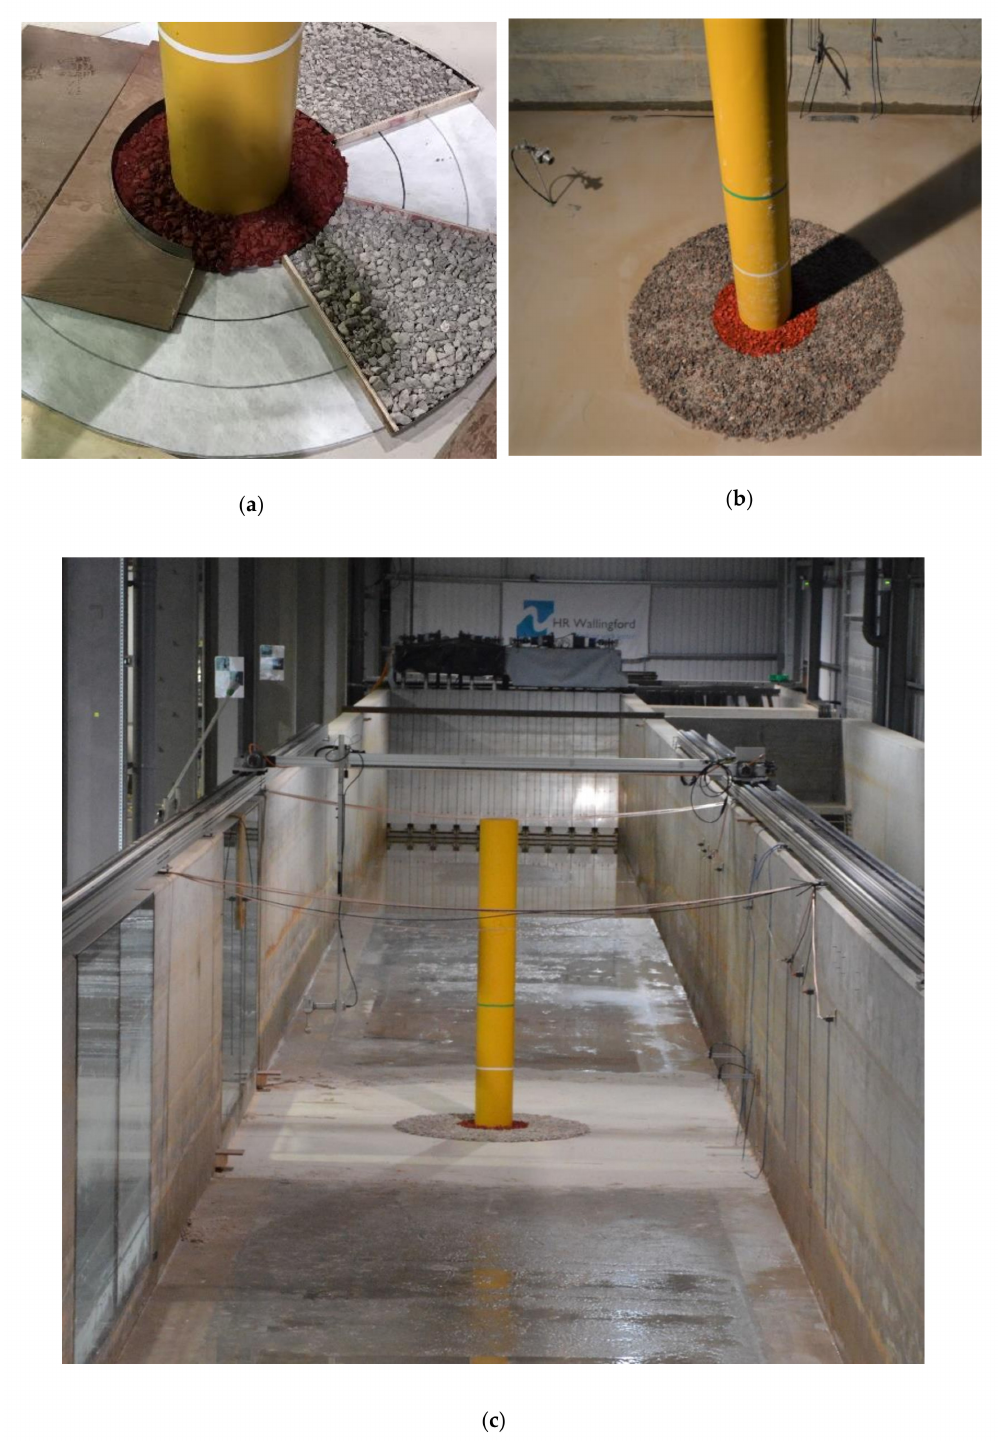
Figure 5. Experimental set-up in PROTEUS project: ( a ) Scour protection layer installation; ( b ) A physical model ready before filling the wave flume; ( c ) Monopile scour protection model in